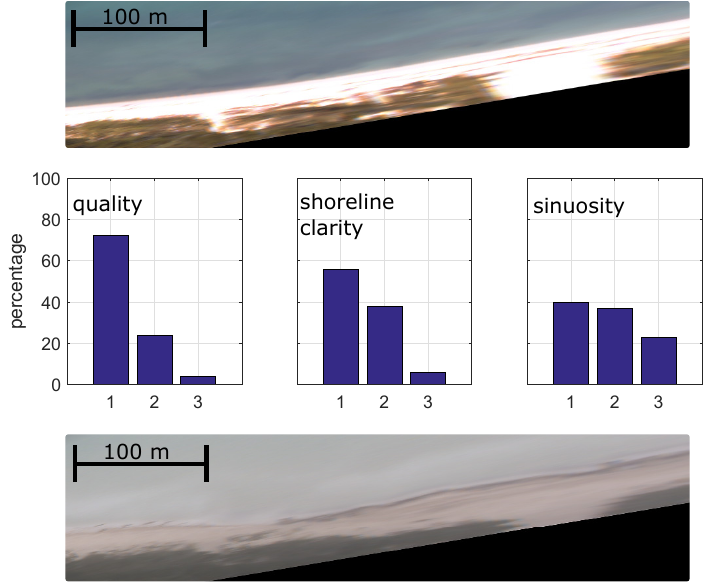
Figure 10. Classification of images based on quality (1 higher quality), shoreline clarity (1 more clear) and shoreline sinuosity (1 less sinuosity). The upper image has a 1, 1, 1 classification and the lower image has a 3, 3, 2